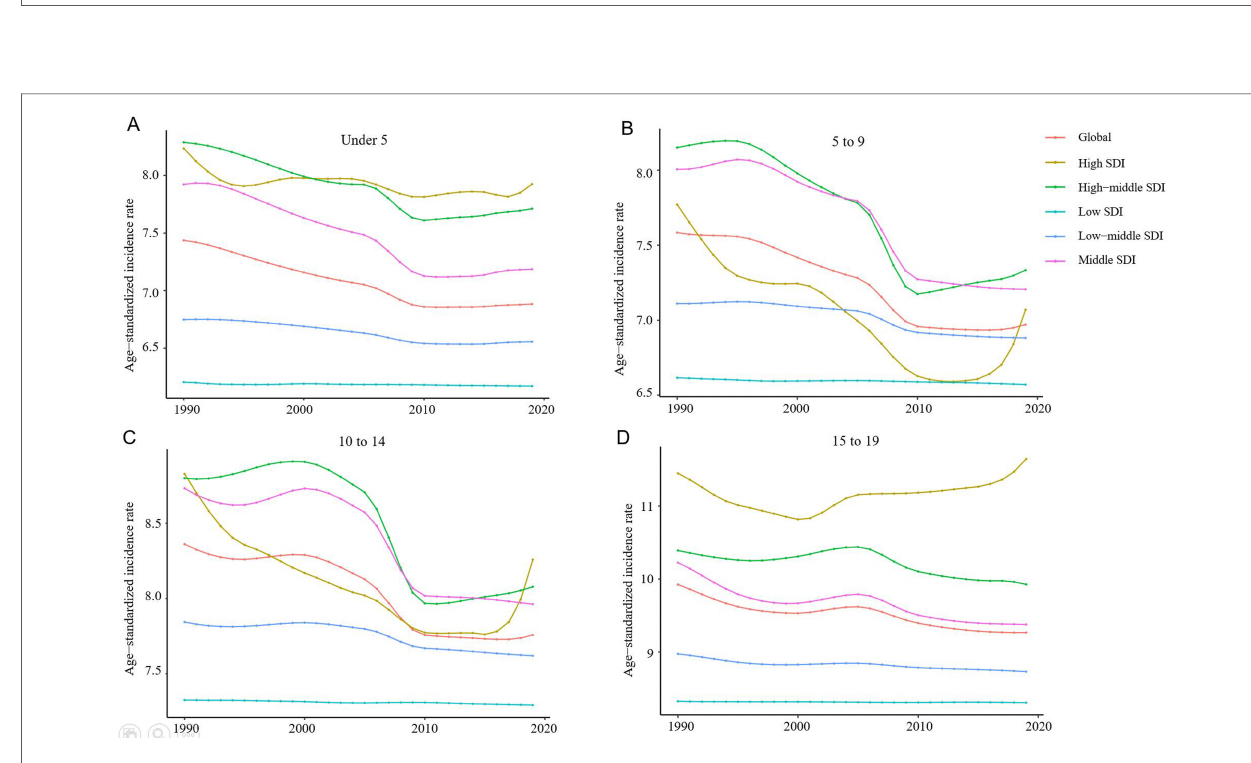
FIGURE 6 Trends in the age-standardized incidence of myocarditis and cardiomyopathy in children of different sex and age group, 1990 – 2019. ( A ) Change in trend of age-standardized incidence rate for under 5-year-olds. ( B ) Change in trend of age-standardized incidence rate for 5 – 9-year-olds. ( C ) The trend of age-standardized incidence in the 10 – 14 age group. ( D ). The trend of age-standardized incidence in the 15 – 19 age group.